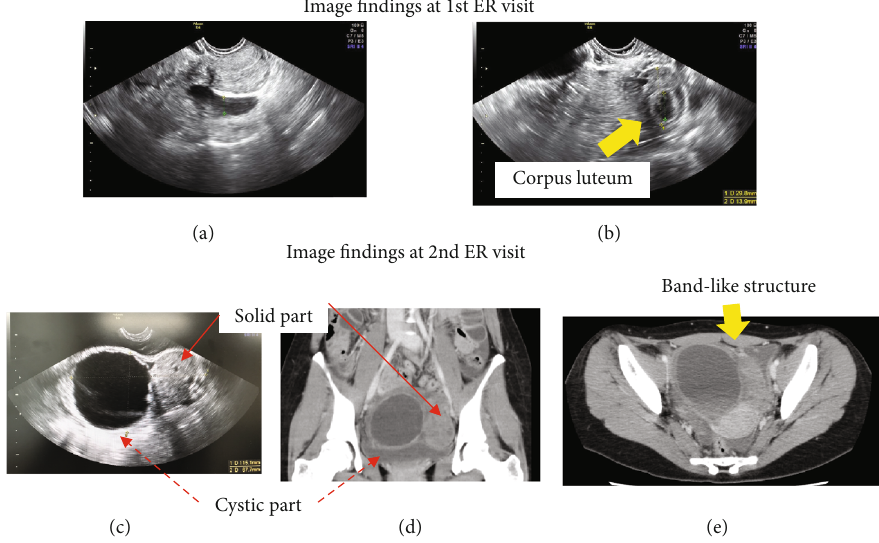
Figure 1: Image fi nding at 1st ER visit and 2nd ER visit. (a, b) Image fi ndings at 1st ER visit. (a) Small amount of ascites on the left side. (b) A left adnexa 3 cm in size, and a small cyst inside that was suspected to be a corpus luteum. (c – e) Image fi ndings at 2nd ER visit. (c, d) There are two-follicular enlargement. (e) A band-like structure between the solid and cystic parts. Arrows are indicated.